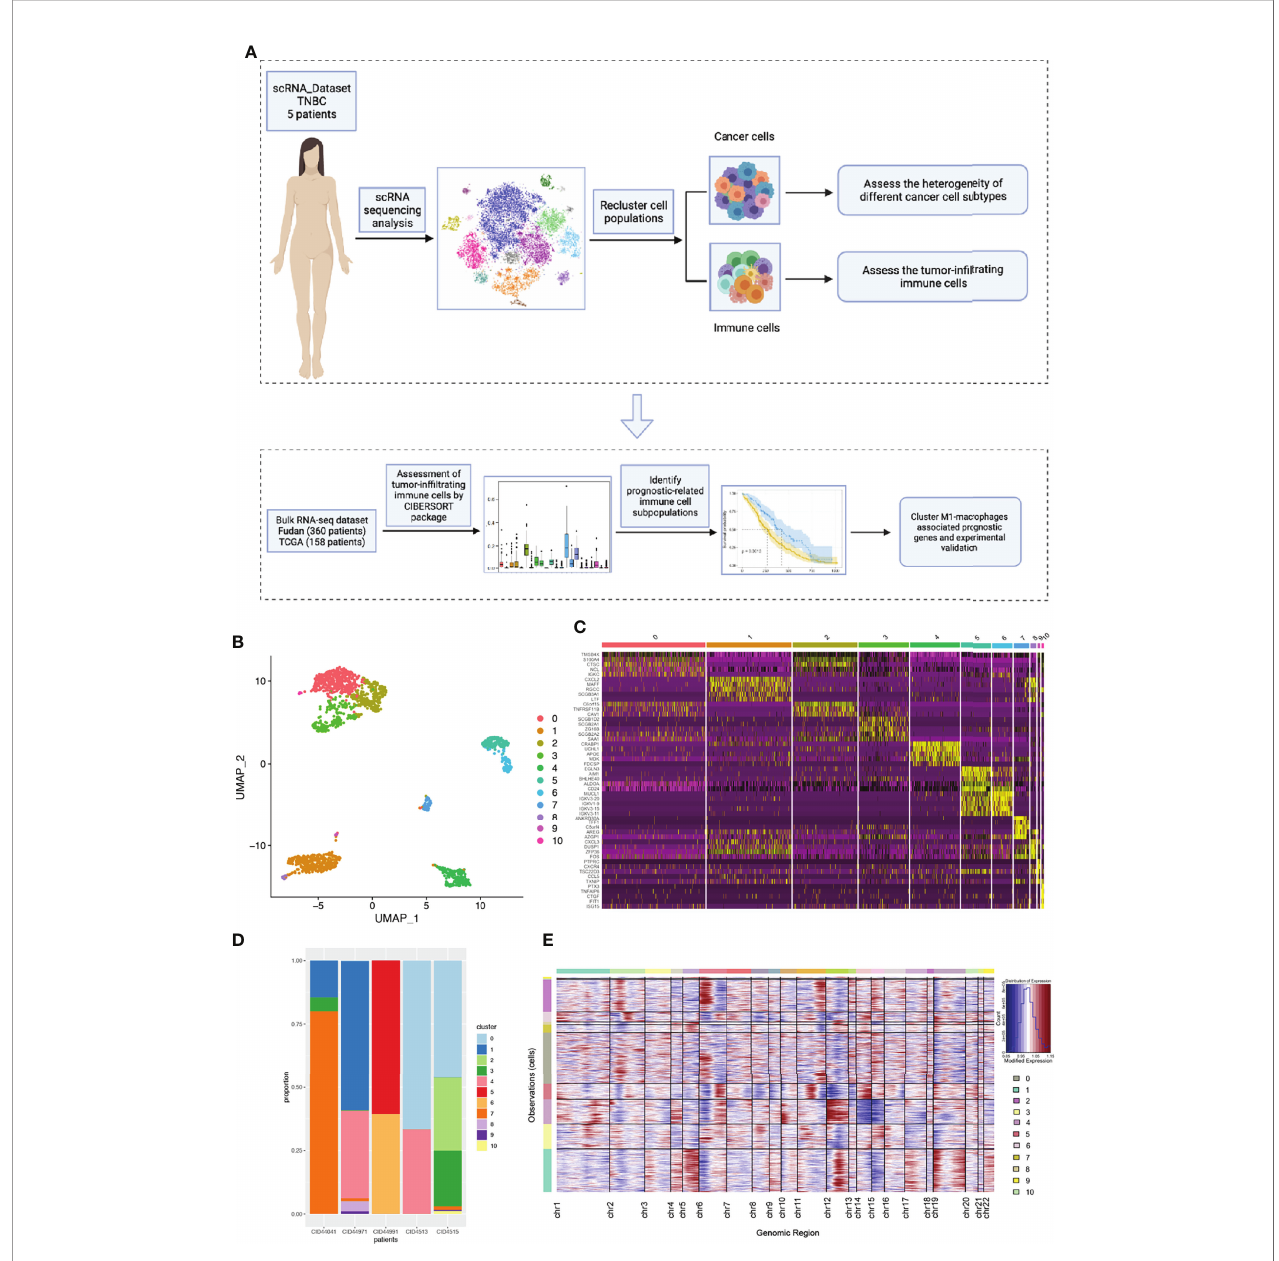
FIGURE 1 | The intra-tumor and inter-tumor heterogeneity of TNBC from scRNA-seq analysis. (A) A brief fl ow chart of the analysis of the entire article is displayed. (B) The malignant epithelial cells were extracted and re-clustered into 11 clusters based on UMAP method. (C) The top5 marker genes of 11 malignant cell clusters were shown in the form of a heatmap. (D) All the cell clusters were detected in each patients, with varying proportions of cell types between cases. (E) We calculated the copy number variants in every cell clusters to estimate mutational differences within